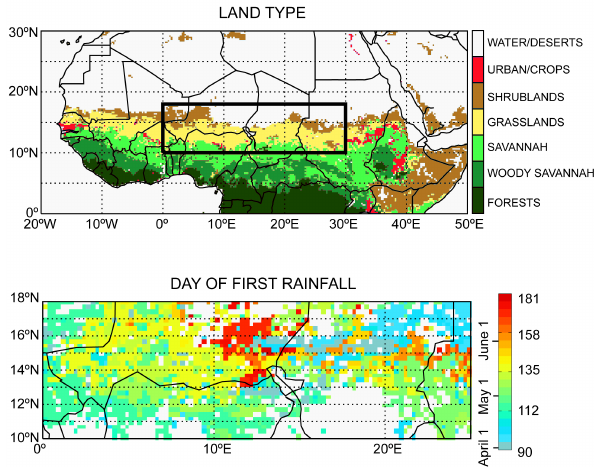
Fig. 7. Land type (top) and first rainfall dates (bottom) over the central Sahel region of northern equatorial Africa (0–30 ◦ W, 10–18 ◦ N, boxed region). Land types were defined using NASA TERRA/MODIS HDF-EOS MOD12Q1 V004 land cover data. First rain is calculated as the date when TRMM total rainfall exceeds 2mm in the 24 h period before the OMI overpass time (13:30 UTC– 13:30 UTC) following a dry spell (at least 60 days of < 2mm day − 1 ) . Regions that do not meet the criteria for dry spell length are shown in white.